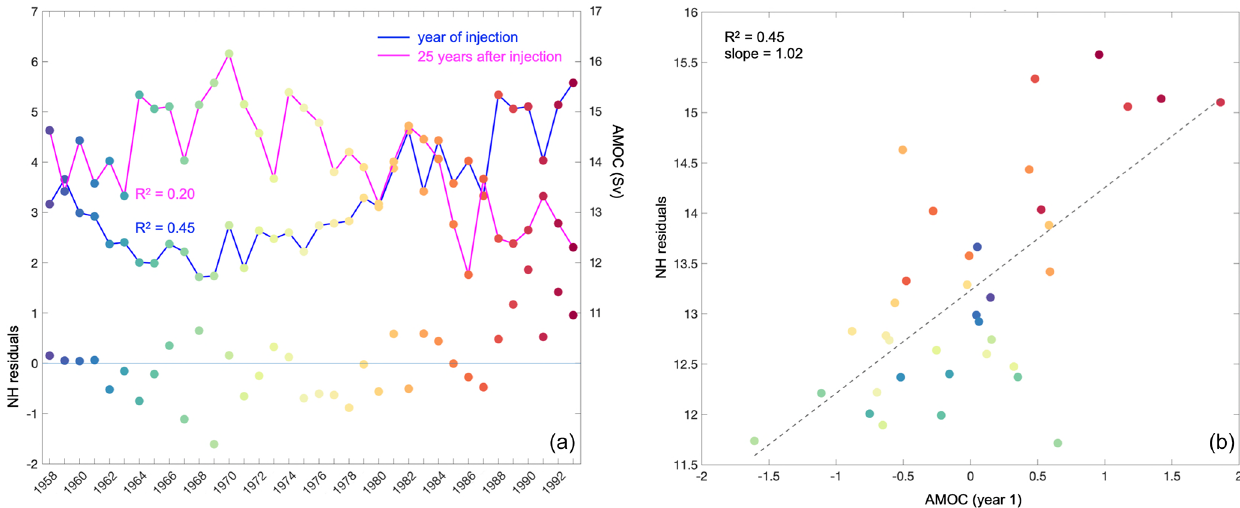
Figure 13. Time series of the AMOC at 26 ◦ N at 1000m and Northern Hemisphere residuals of the correlation in Fig. 10b (a) , and the correlation of the AMOC against the residuals (b) from panel (a)